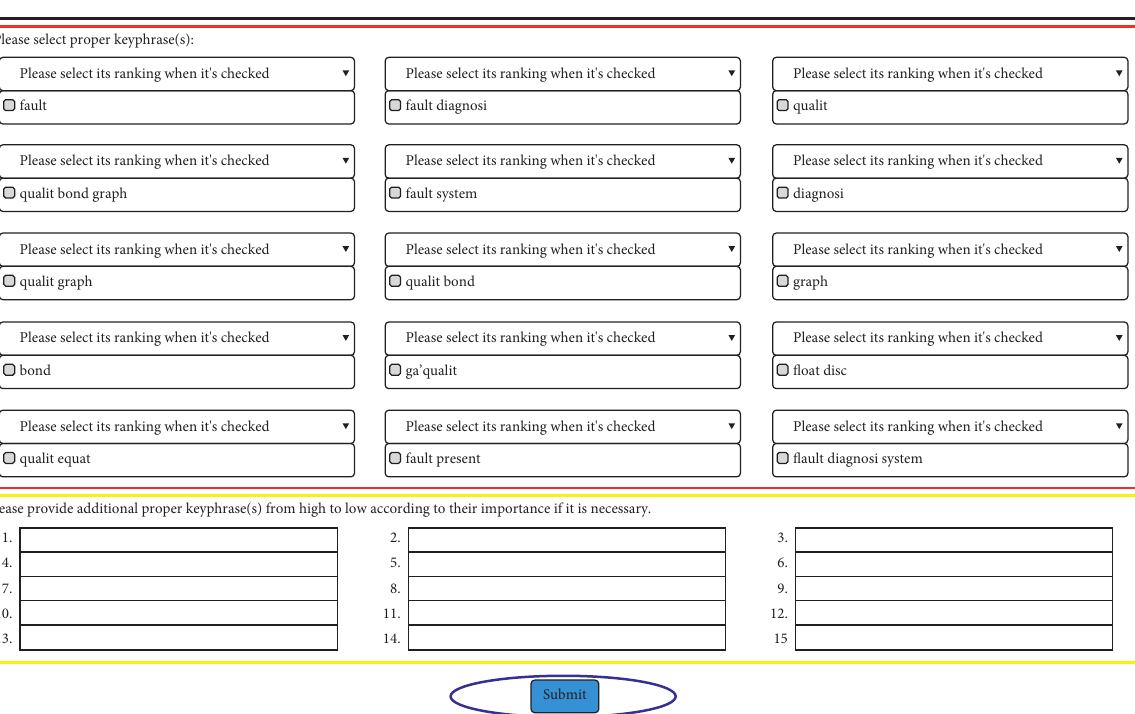
Figure 1: The main user interface of a single